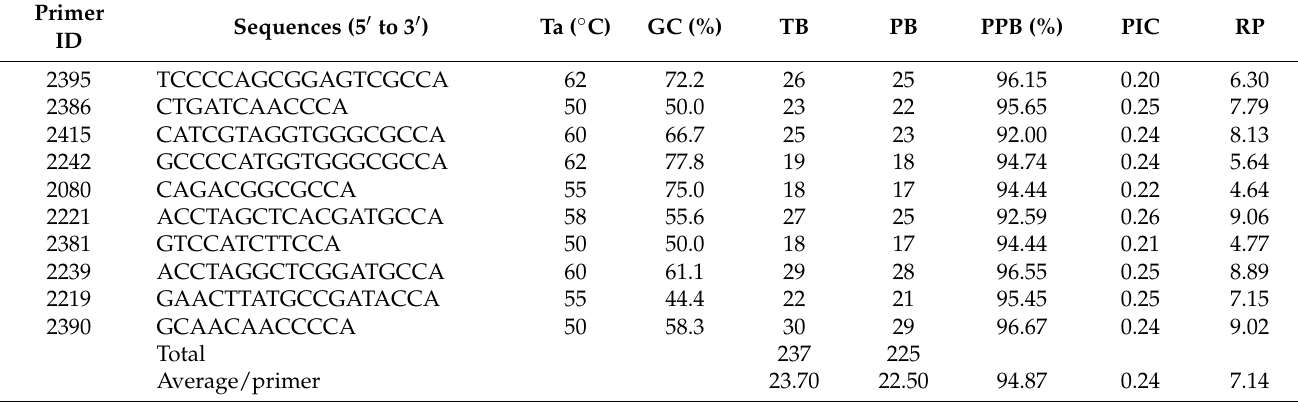
Table 2. Information on the PBS primers used to evaluate entomopathogenic fungal